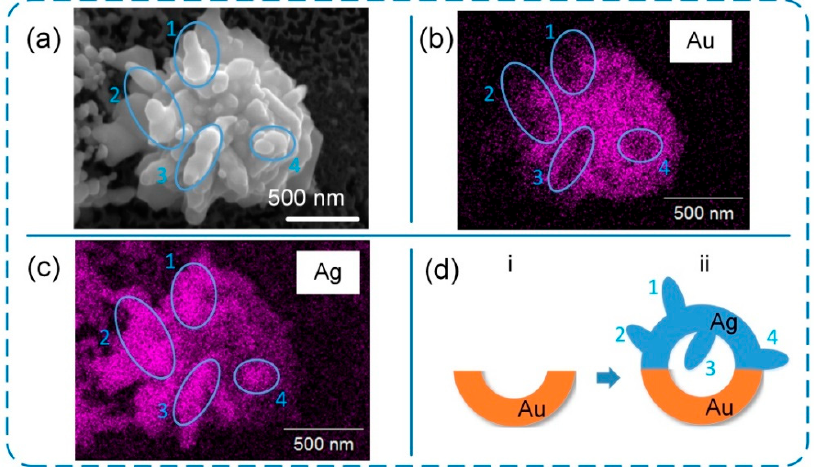
Figure 6. Silver/gold hybrid nanostructure. ( a – c ) SEM image and corresponding EDS mappings of Au and Ag. ( d ) Schematic illustration of single Ag/Au hollow nanocluster.